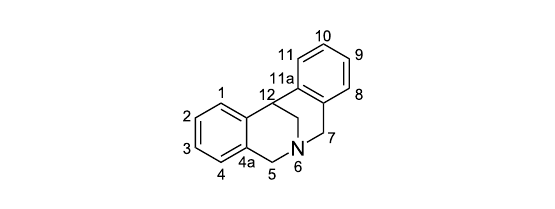
Figure 2: The structure and numbering of dihydromethanodibenzoa-